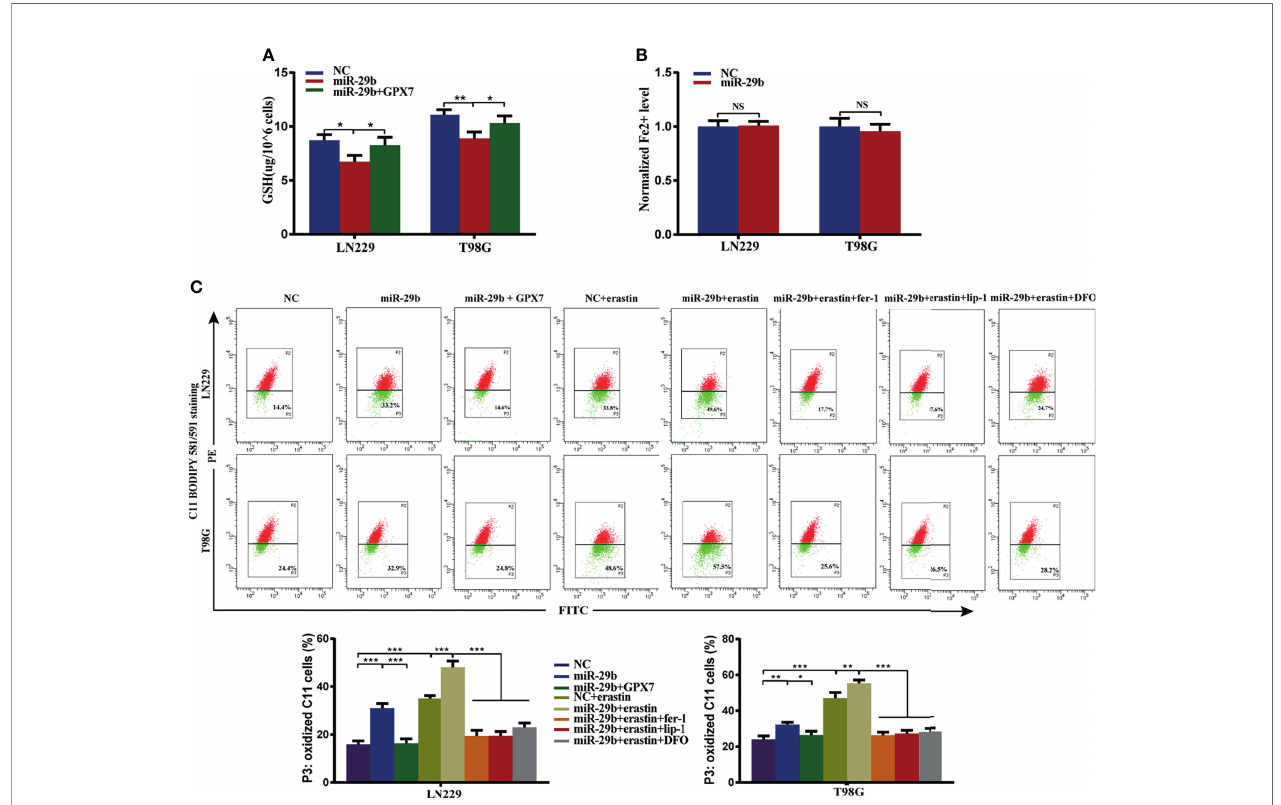
FIGURE 7 | GPX7 restoration can reverse miR-29b mediated enhancement of ferroptosis-related oxidative stress. LN229 and T98G cells were transfected with miR- 29b mimic or cotransfected with miR-29b mimic and GPX7 overexpression plasmid. (A) The reduced GSH level of cells. (B) The Fe2+ concentration was measured by FerroOrange probe. (C) Lipid peroxidation was detected in glioma cells treated with or without fer-1 (2 m M), erastin (10 m M), lip-1 (100 nM) and DFO (100 m M). Within each chart, cells in P3 region in green represent those stained with oxidized dye. *P < 0.05, **P < 0.01, ***P < 0.001. ns, not signi fi